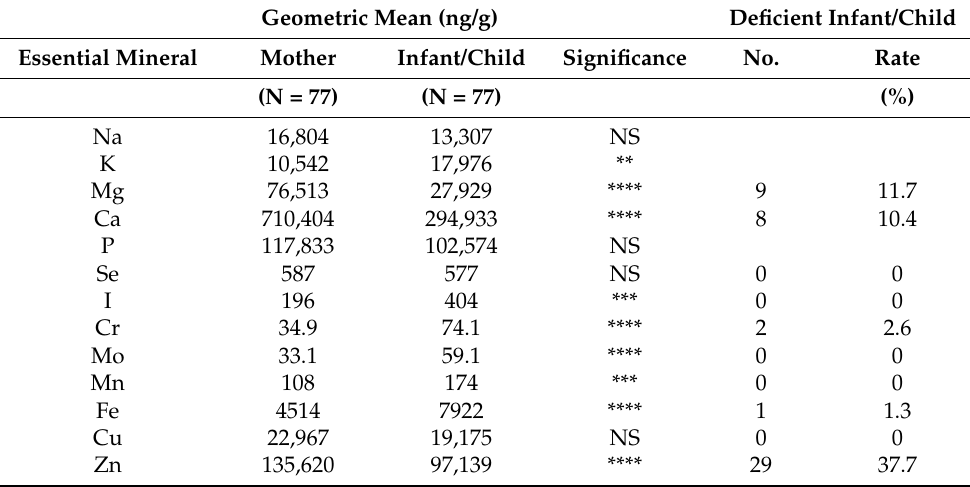
Table 2. Mean essential mineral concentrations in scalp hairs of infant/child and their mother. Geometric Mean (ng/g) Deficient Infant/Child